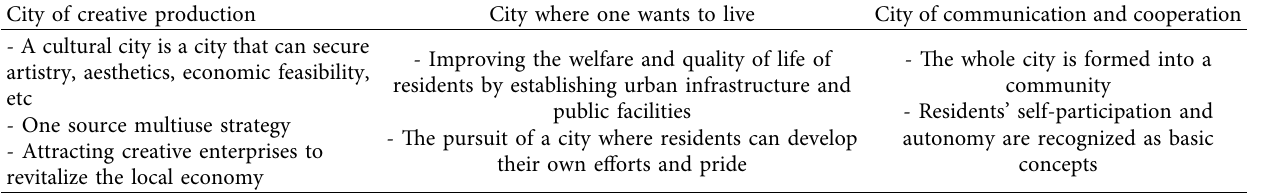
Table 10: Meaning and direction of culture